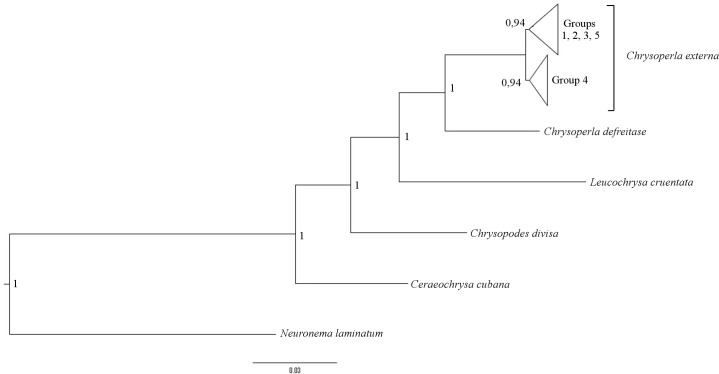
Bayesian inference analysis for the concatenated genes of Chrysoperla externa.The node type represents Bayesian posterior probability.